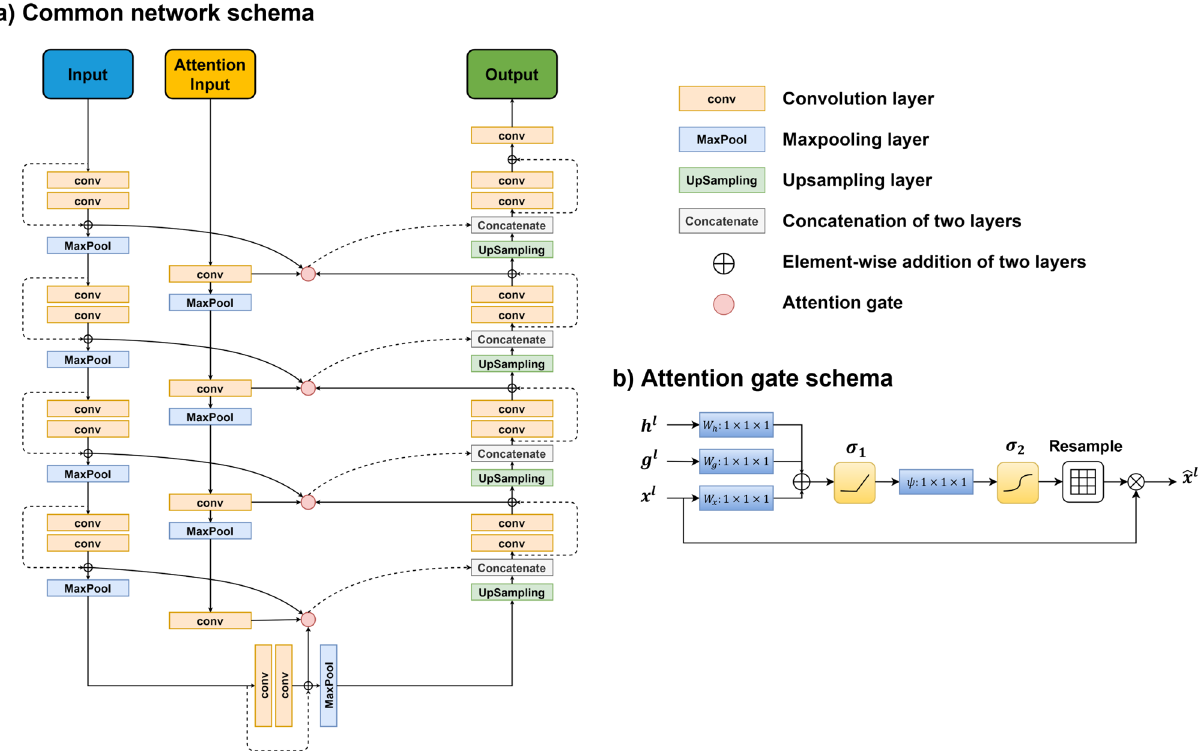
Figure 4. Common network scheme. ( a ) Common network structure for estimating the residual DVF using U-Net backbone with residual blocks and an auxiliary attention path. ( b ) The schema for attention gate at each block, with h representing gate signal from encoding pathway, g representing gate signal from auxiliary attention path, and x representing the layer at decoding pathway. The resulted ˆ x will be concatenated to the decoding